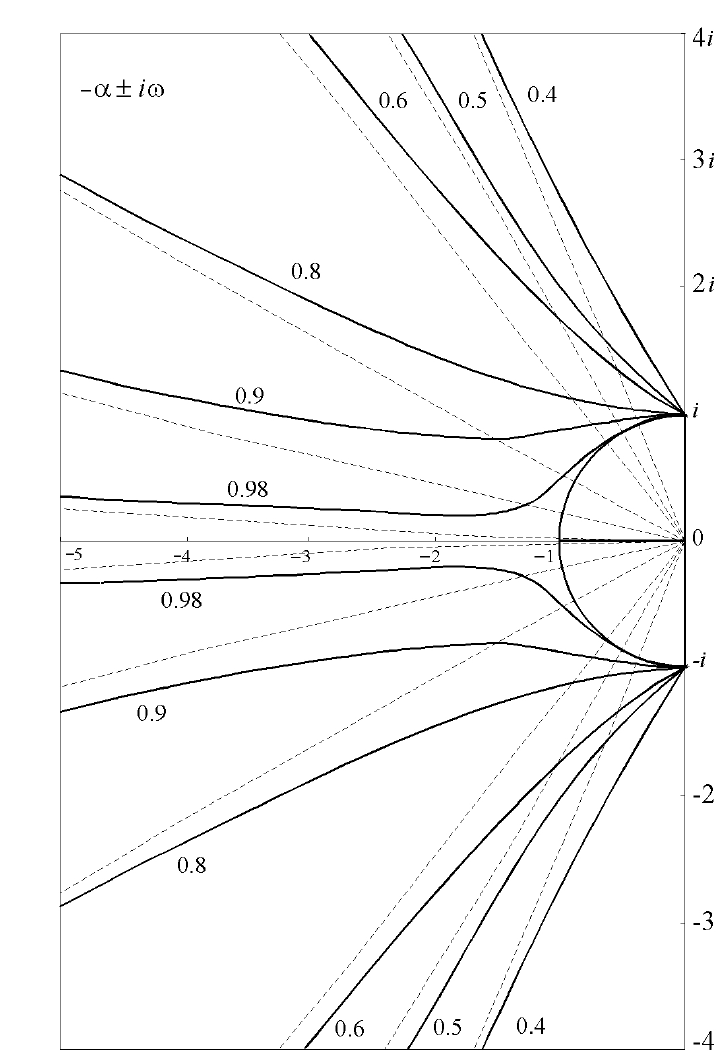
Fig. 1. The behavior of the complex conjugate roots for the Kelvin-Voight fractional